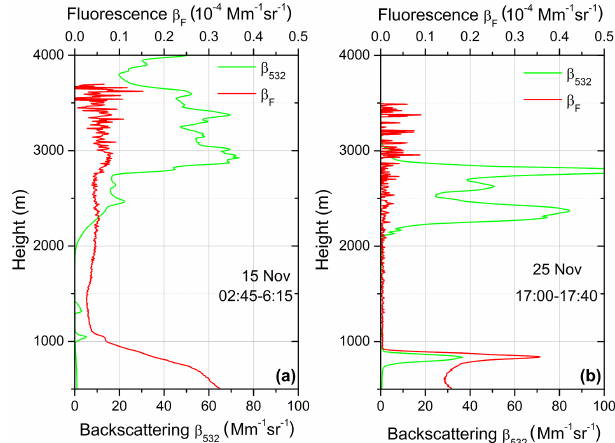
Figure 8. Aerosol ( β 532 ) and fluorescence ( β F ) backscattering co- efficients on (a) 15 and (b) 25 November